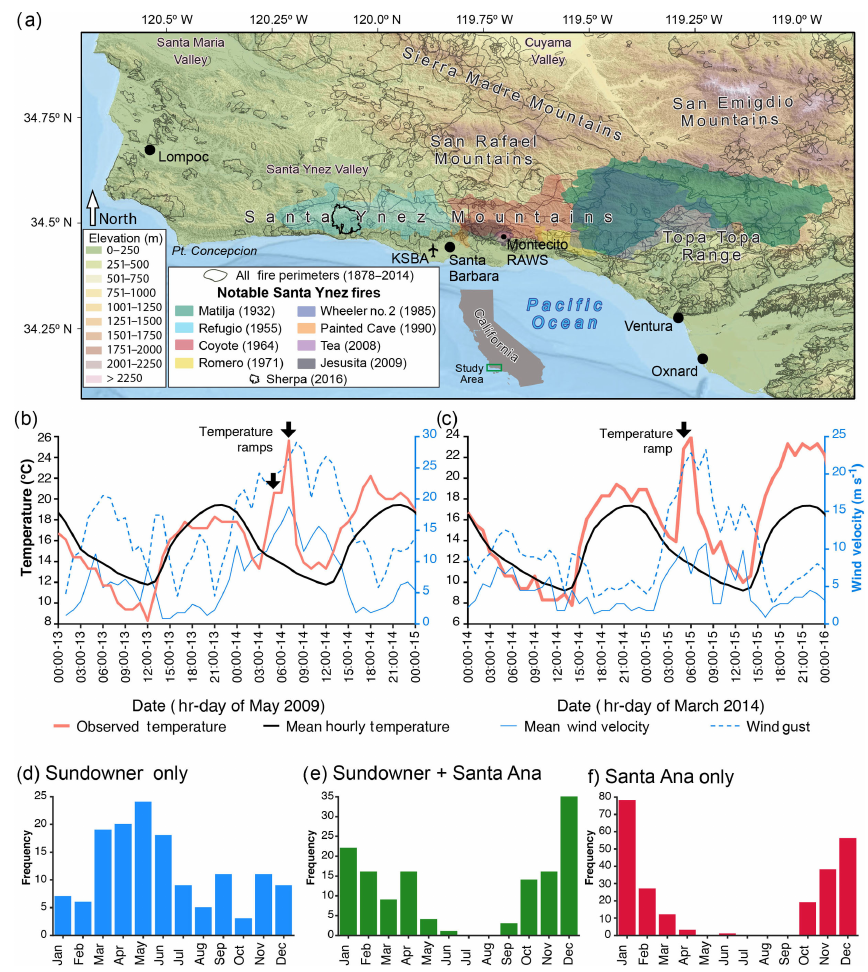
Figure 1. (a) Map of the study area. Notable fire perimeters with impact on urban communities and agricultural operations are colored. The Santa Barbara Airport (KSBA) weather station was used to estimate temperature ramps produced by Sundowner wind events and the Montecito RAWs were used to evaluate winds during Sundowner conditions. (b, c) Examples of two characteristic temperature increases (temperature ramps) that occur outside of the month-averaged diurnal heating cycle (black line). The right y axis shows temperature at KSBA and the left y axis shows Montecito RAWs wind speed and gust velocity. (d–f) Monthly frequencies of (d) top 0.5% of Sundowner-only events, (e) top 0.5% of Sundowner events and any 6h period of Santa Ana winds events (Sundowner + SAW in the text), and (f) top 2% Santa-Ana-only (SAW in the text) events. Note differing y -axis